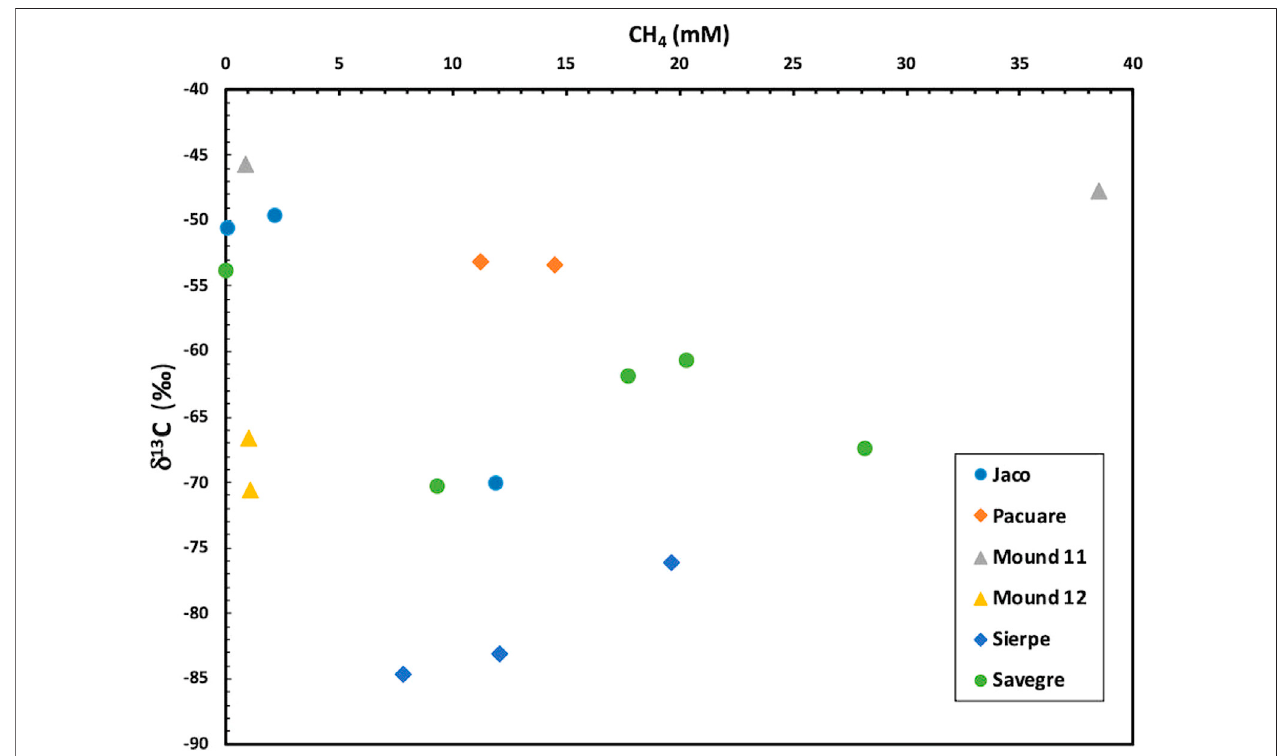
FIGURE 7 | Headspace methane gas concentration vs. carbon isotope ratio of methane. Methane gas concentration ranges from negligible to 38.5 mM, and carbon isotope ratios range from − 45.7 to − 84.6 ‰ PDB, covering spectrum from thermogenic to biogenic methane. Note that two samples from Mound 11 differ in methaneconcentrationbutyieldsimilarcarbonisotoperatios;thesearetwosamplestakenatdifferentdepthsinsamecoreandsuggestrecentin fl uxofmethaneinorder to create a large concentration